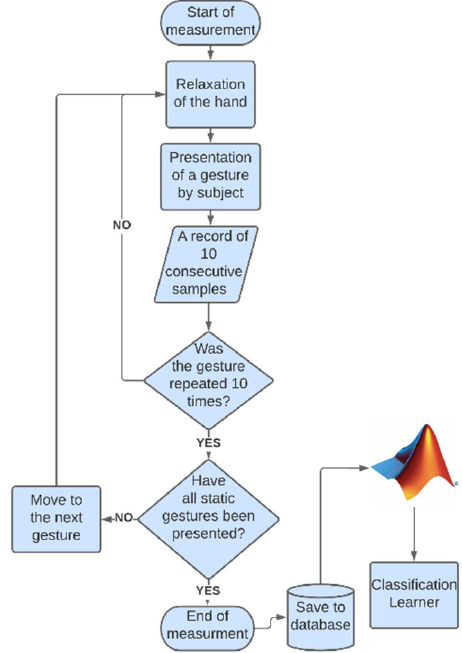
Figure 5. The methodology flowchart.